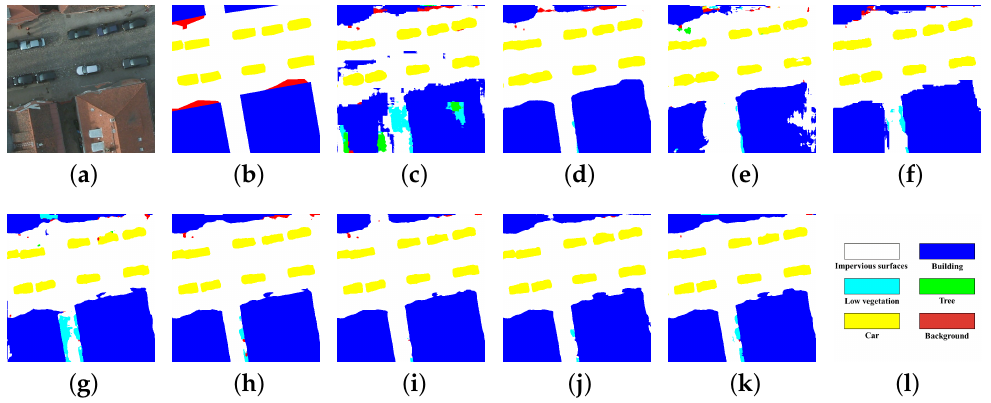
Figure 16. Segmentation results on the Potsdam dataset with different models. ( a ) Image; ( b ) Ground Truth; ( c ) FCN-8s; (d) PSPNet; ( e ) Deeplab V3+; ( f ) HRNet V2; ( g ) SDFCN V1; ( h ) SDFCNv2;